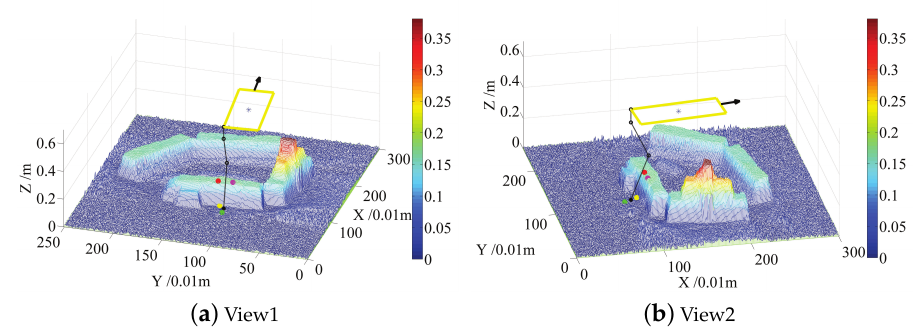
Figure 9. Candidate footholds randomly sampled around the left back default foothold for expert, and expert will sort these footholds by looking from several clear views. ( a ) the first view from which the expert can judge that the candidate foothold lies to the left of the default foothold or right; ( b ) the second view from which the expert can judge that the candidate foothold lies at the front of the default foothold or